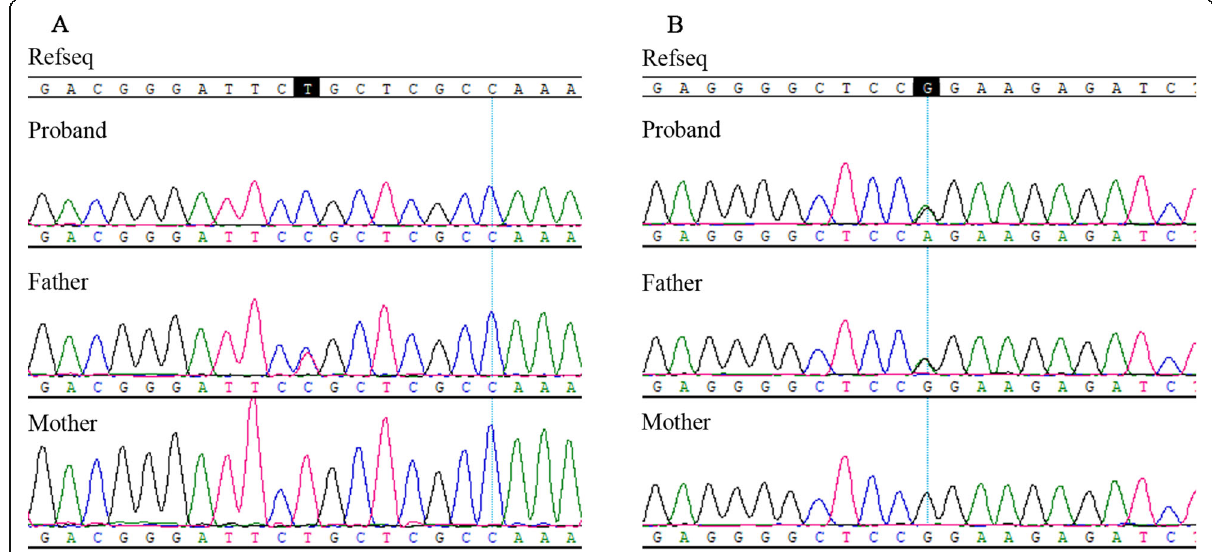
Fig. 3 Confirmation of two mutations by Sanger sequencing. a OCA2 NM_000275: c.1865 T > C (p.Leu622Pro). b MYO7 NM_000260: c.4805G > A (p.Arg1602Gln)